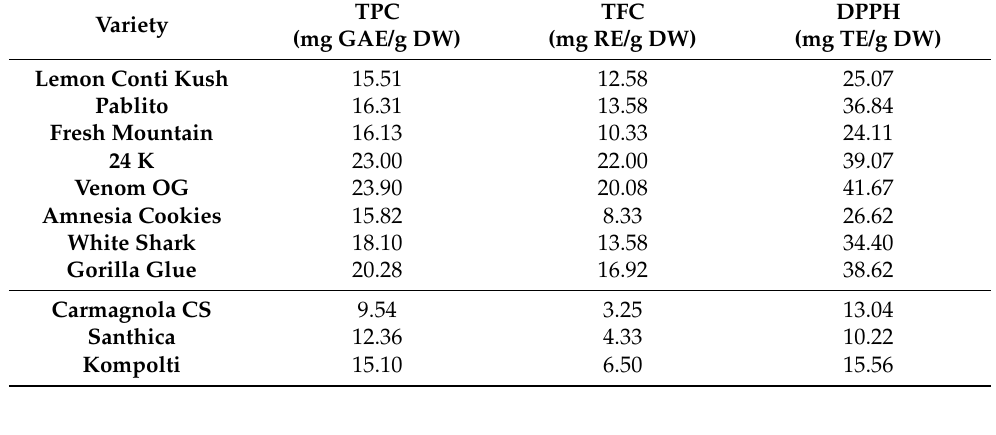
Table 6. TPC, TFC, and antioxidant activity results for the 9 commercial varieties DM.